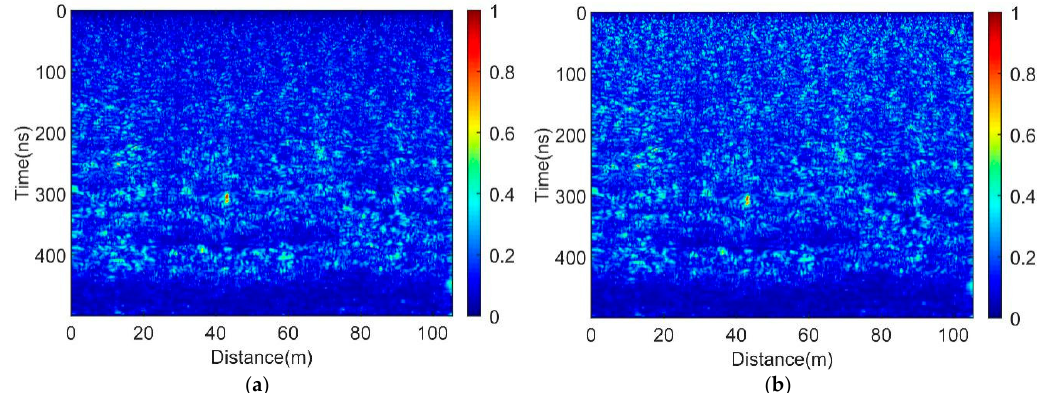
Figure 5. 3D velocity spectrum.